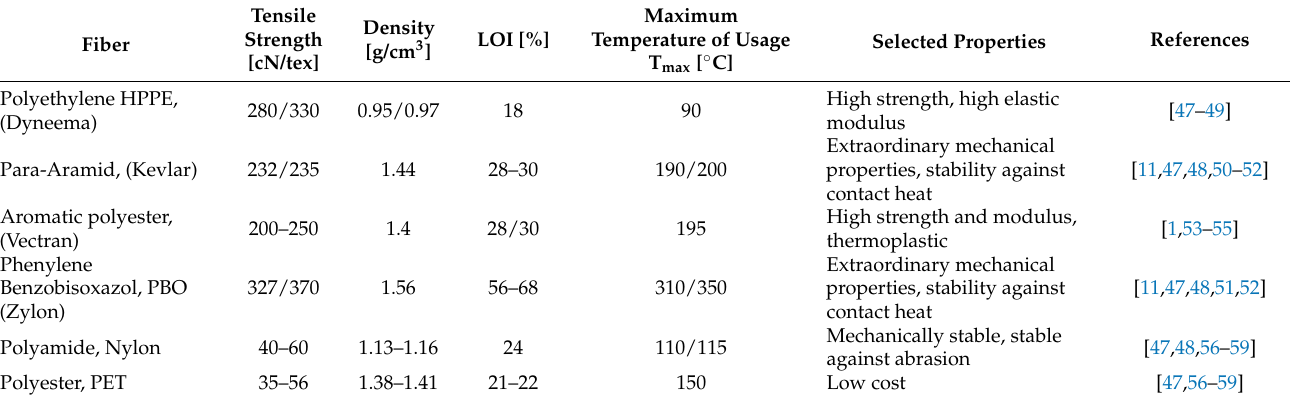
Table 1. Comparison of properties of some high-strength fibers.